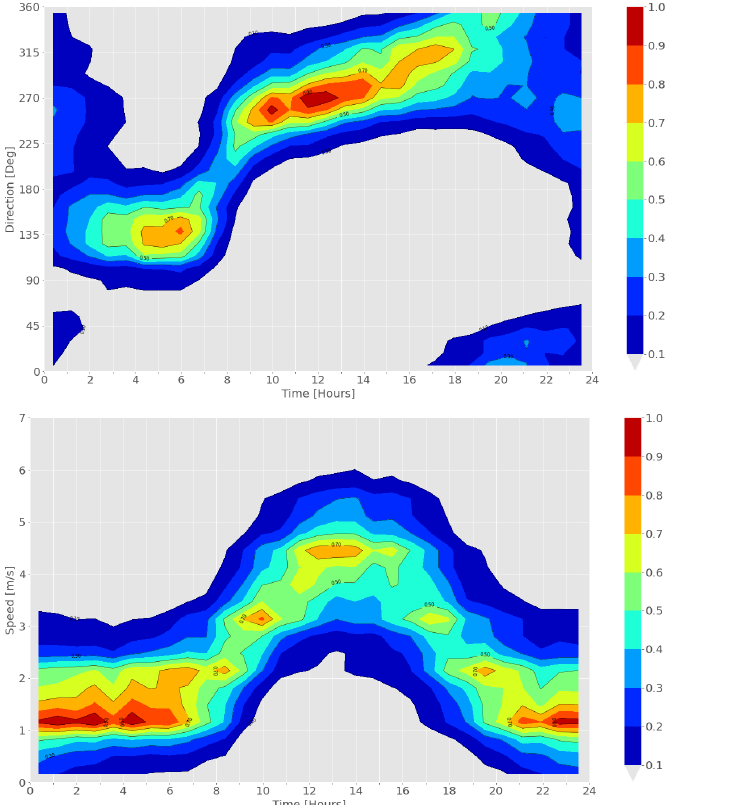
Figure 2. Nonparametric bivariate density of the climatological Tel Aviv summer wind diurnal distribution: upper: wind direction, lower: wind speed. The colored contours represent a given fraction of the distribution. All time points are in LST (UTC +